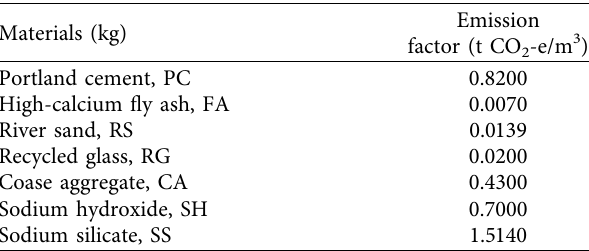
Figure 8: Relationship between normalized fexural strength and curing time of AAFA mortar containing RG by the 28-day fexural strength. Table 3: Te emission factors of tested materials [13,